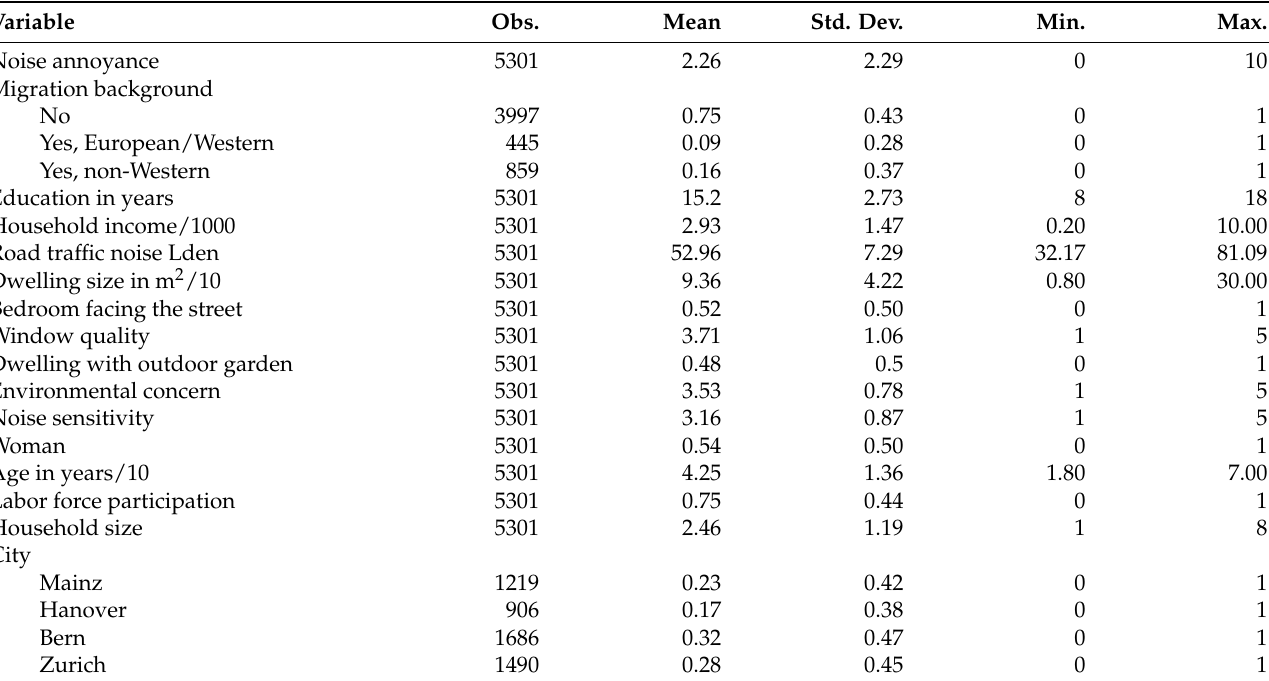
Table 1. Variables and their descriptive